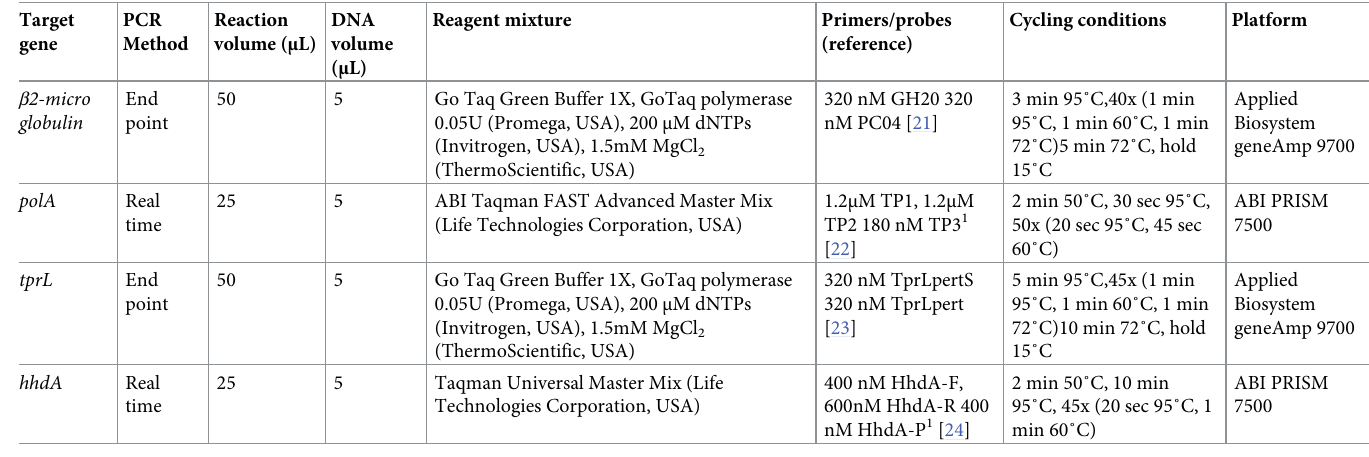
Table 1. Polymerase chain